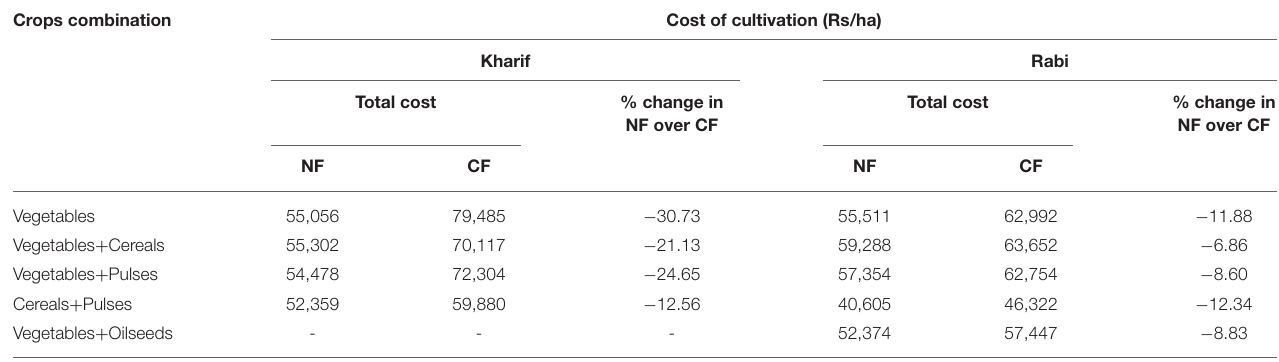
TABLE 14 | Cost of cultivation of various crop combinations under NF and CF systems. Crops combination